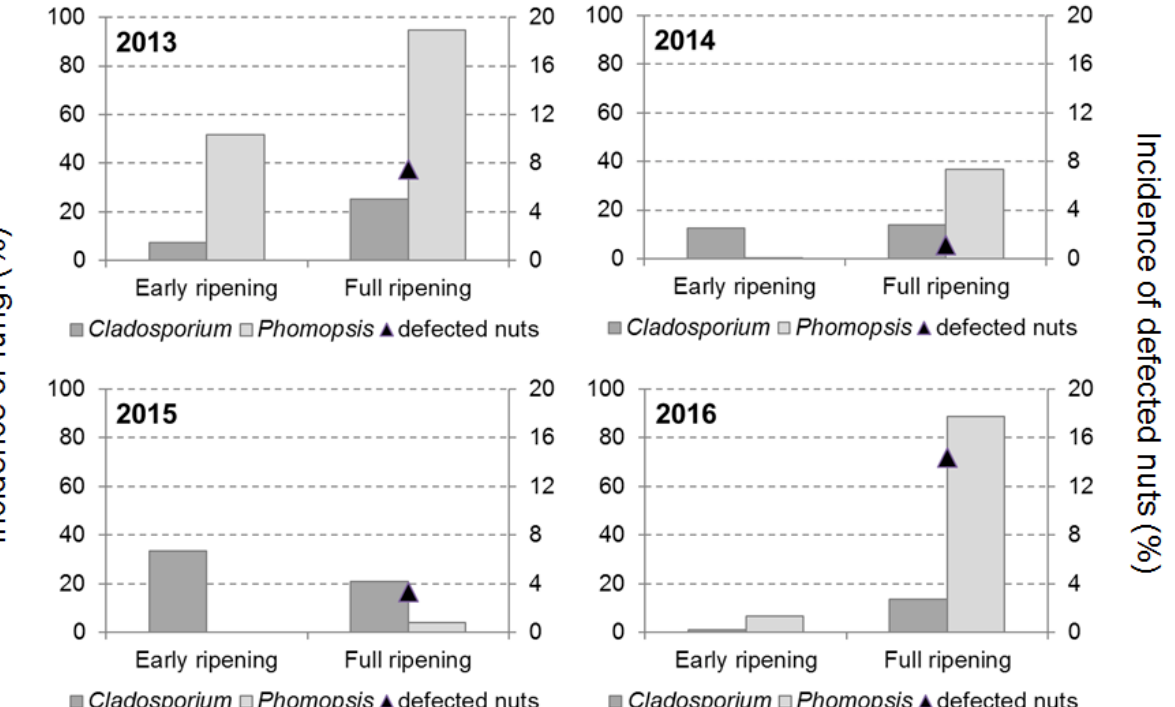
Figure 3. Incidence of Cladosporium spp. and Diaporthe spp. from hazelnuts at early or full ripening stages, and incidence of defects in nuts collected from 10 ha